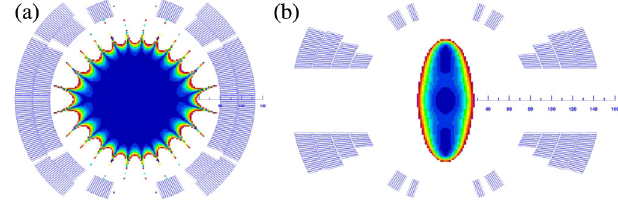
FIG. 5. Cross sections and a good-field region of the dipole B1 based on cos (cid:10) (left) and open midplane (right) coil design. The dark blue color corresponds to the field error of j (cid:2)B=B j < 10 (cid:2) 4 .